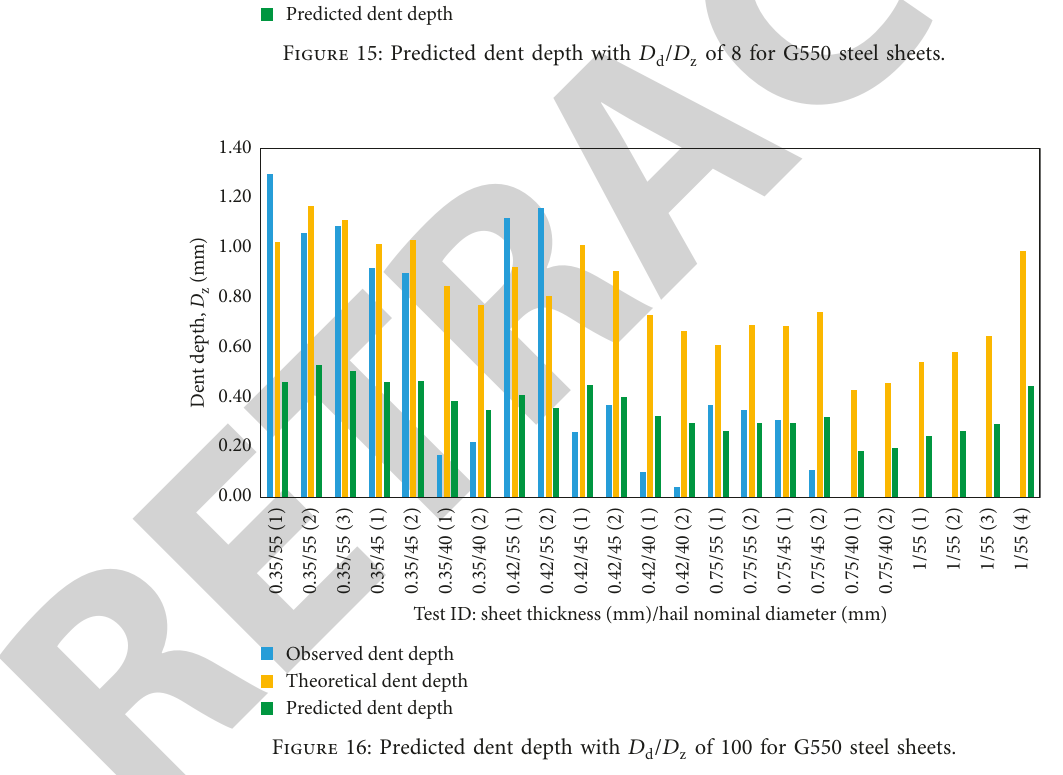
Figure 15: Predicted dent depth with D